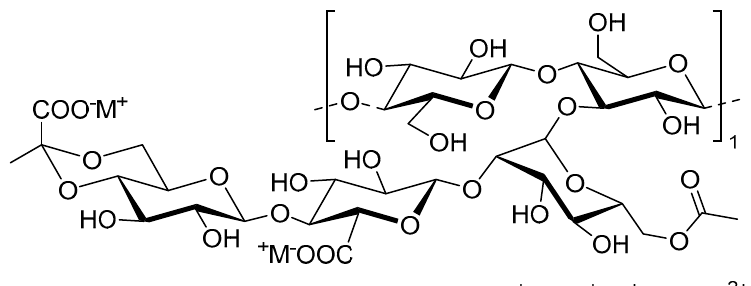
Figure 8. Xanthan gum structure.